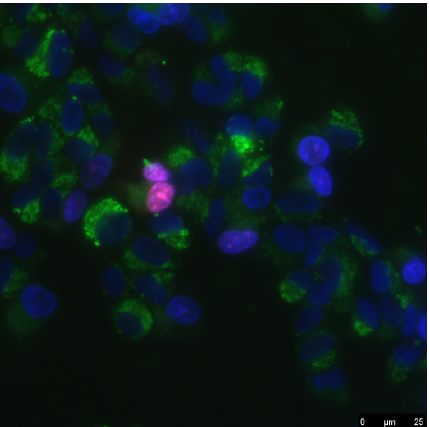
Figure 1. The sample of cell culture micrograph. The mitochondria of the cells are colored green; they can be used to estimate the size of the cells. Normal cell nuclei are colored blue. Nuclei of non-viable cells are stained in purple.